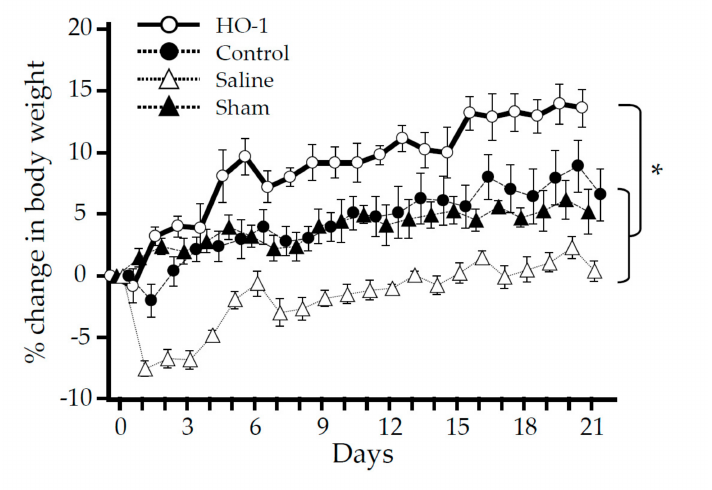
Figure 7. E ff ect of nasal administration of HO-1 lactis on PPE-induced weight loss. Mice were treated as described in Figure 5. The percent change in body weight was determined for each animal at each time point. Statistical significance was determined based on area under the curve (baseline minimum) of the percent change in body weight measurements in each mouse. Results represent the mean ± SE of each group from 2 independent experiments involving a total 5 to 6 mice / group. *, p <